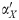
Results given for various combinations of αX and αY in unassociated datasets outperformed Pearson correlation coefficient in the majority of cases.The figure is arranged in the exact same way as Fig 2. IX and IY were calculated independently for the dataset to be unassociated and X was calculated by the addition of IX and NX and similarly Y. The value of BPA obtained is encoded in color, the darker being higher. As in Fig 2, below every heatmap the corresponding scatterplot for X and Y is shown. The straight black line shows the relationship function. On the top of every heatmap the normalized mutual information content (MI), the Bayesian Probability of Association (BPA, for the correct choice of αX′ and αY′ which is equal to αX and αY respectively) and the Pearson correlation value (PC) has been displayed. On the top of every scatter plot, the values of the Spearman Rank Correlation (SR) and the Kendall Tau Rank Correlation (KT) is also shown.